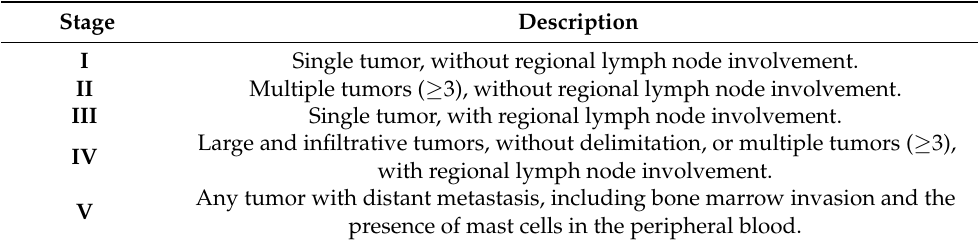
Table 3. Clinical Staging system for Canine Cutaneous Mast Cell Tumors proposed by Horta et al. [11,27], Adapted from the World Health Organization